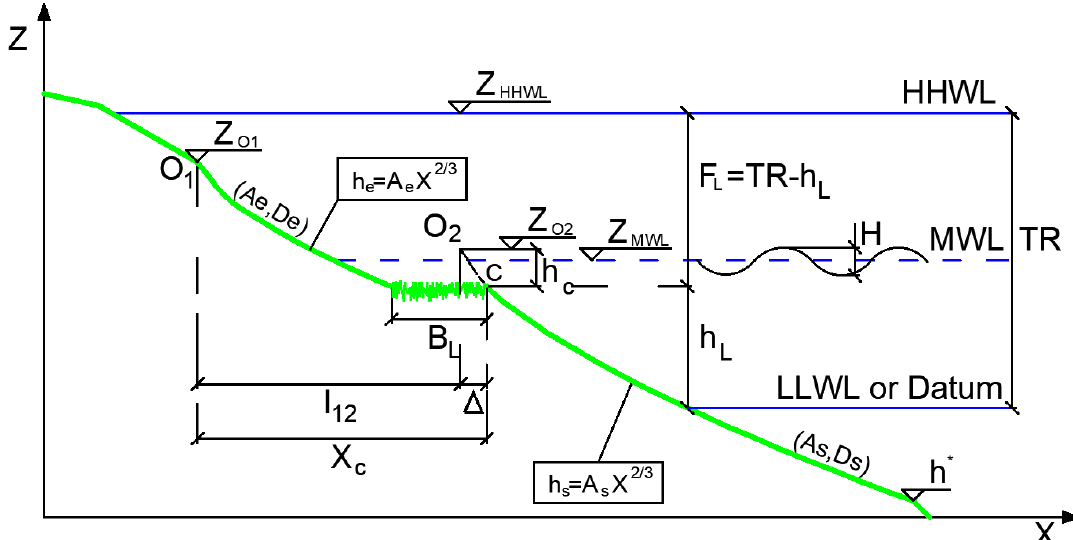
Figure 1. Sketch of a typical bi-parabolic profile in a reef coast. Different parameters are shown. Maritime climate: Highest High Water Level (HHWL), Level of the HHWL (Z HHWL ), Mean Water Level (MWL), Level of the MWL (Z MWL ), Lowest Low Water Level (LLWL) or Datum, Tidal Range (TR), wave height (H). Morphological parameters: Origin of the emerged (O 1 ) and submerged (O 2 ) parables, O 1 Level (Z O1 ), O 2 Level (Z O2 ), horizontal distance between O 1 and O 2 (I 12 ), emerged (Ae) and submerged (As) shape parameter, D 50 or average diameter of the emerged (D e ) and submerged (D s ) zones, beginning of the submerged parabola (C), horizontal distance between O 1 and C (X C ), Length of the reef flat (B L ), freeboard (F L ), reef level (h L ), vertical distance between O 2 and reef level (h c ), closure depth (h * ), level of the profile (Z), and horizontal distance of the profile (X).